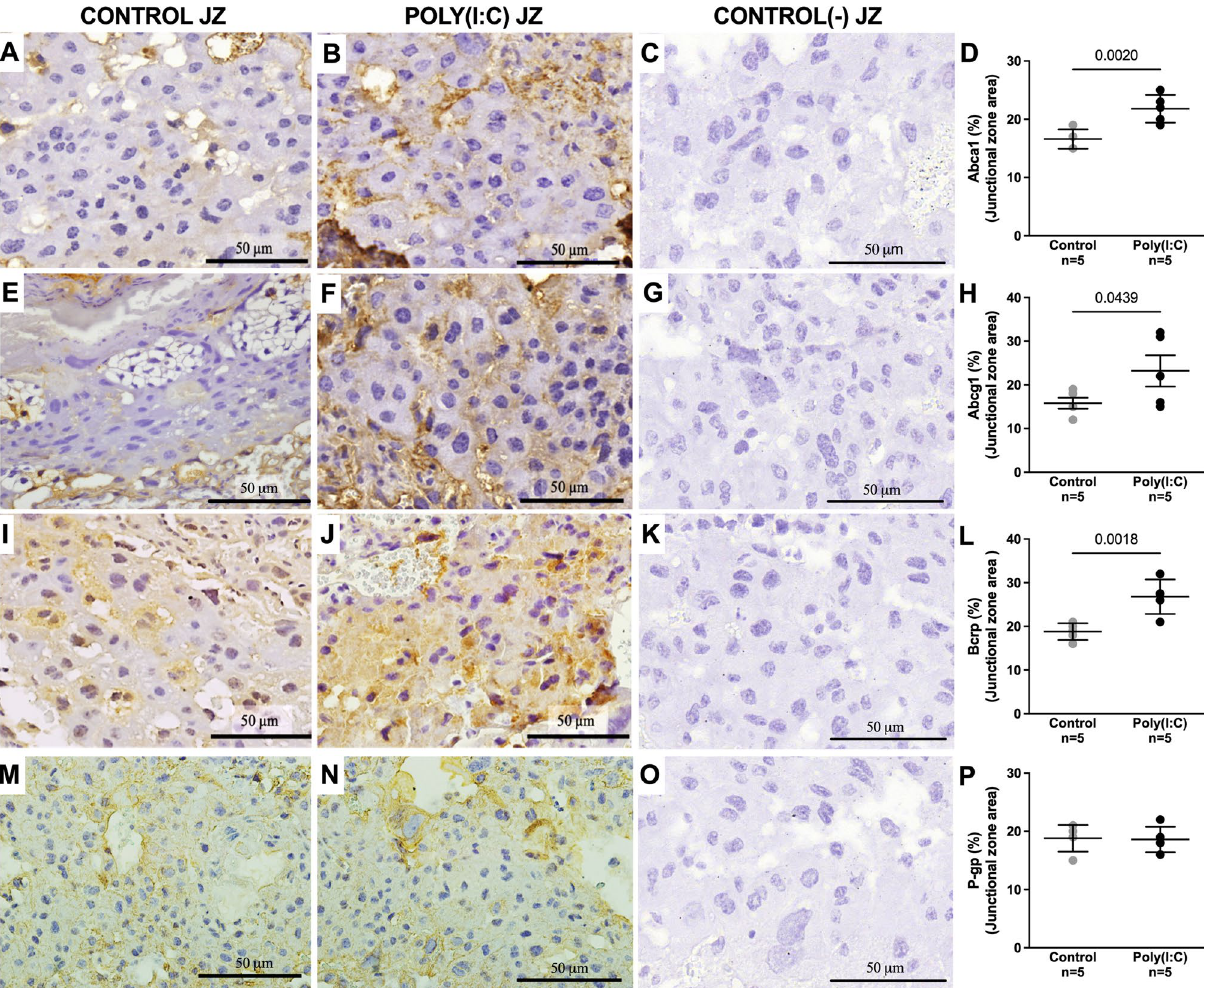
Figure 5. Mid-pregnancy poly(I:C) infection increases Abca1, Abcg1 and Bcrp immunostaining in the placental junctional zone (Jz) at term. Representative images of Abca1 ( A – D ), Abcg1 ( E – H ), Bcrp ( I – L ) and P-gp ( M – P ) staining and their respective quantifications. The graphs were plotted in aligned dot plot, the gray circles represent the control group, and the black circles represent the poly(I:C) group. Negative controls ( C , G, K and O ) were performed with the omission of the primary antibody. Values are expressed as mean ± SD. Student’s t test was